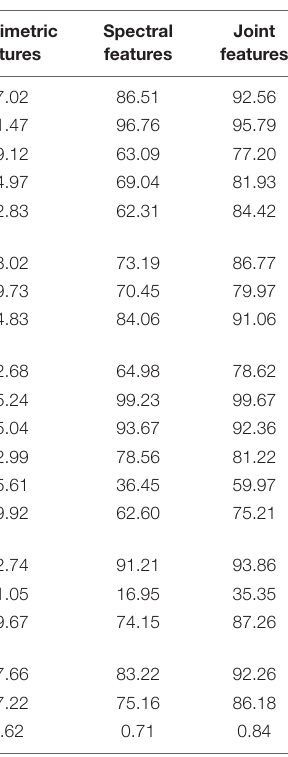
TABLE 4 | Wetland object type extraction accuracies of November 2018 data for RF classification using different